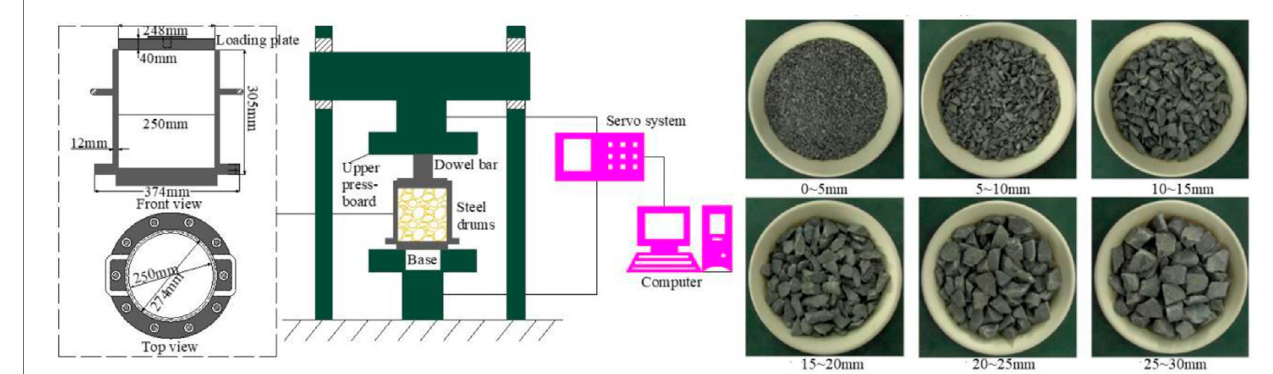
FIGURE 3 | Test system and gangue samples.